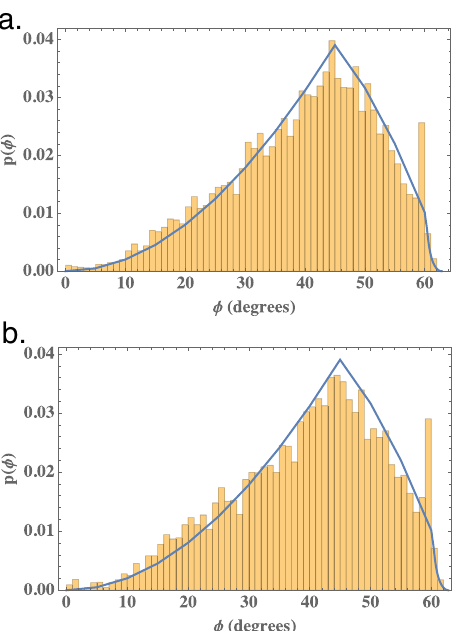
Fig. 5 The partial and mark correlation function for triple junctions. a The correlation function ratio, g αβ r ð Þ = g r ð Þ , versus r / d ( t ) for Al fi lms under the same conditions as listed in Fig. 1a. The disorientations, ϕ , considered here are in the interval [55.0 o , 61.0 o ]. The relative partial pair correlation function for disorientations close to the twin disorientation of 60 o do not indicate strong spatial correlations, suggesting that the associated grain boundaries are essentially randomly distributed in the microstructure. The as- deposited (annealed) results are shown in blue (gold). b The mark correlation function, m αα ( r ), versus r / d ( t ) for Al fi lms under the same conditions as listed in Fig. 1a. ϕ is in the interval [50.0 o , 60.0 o